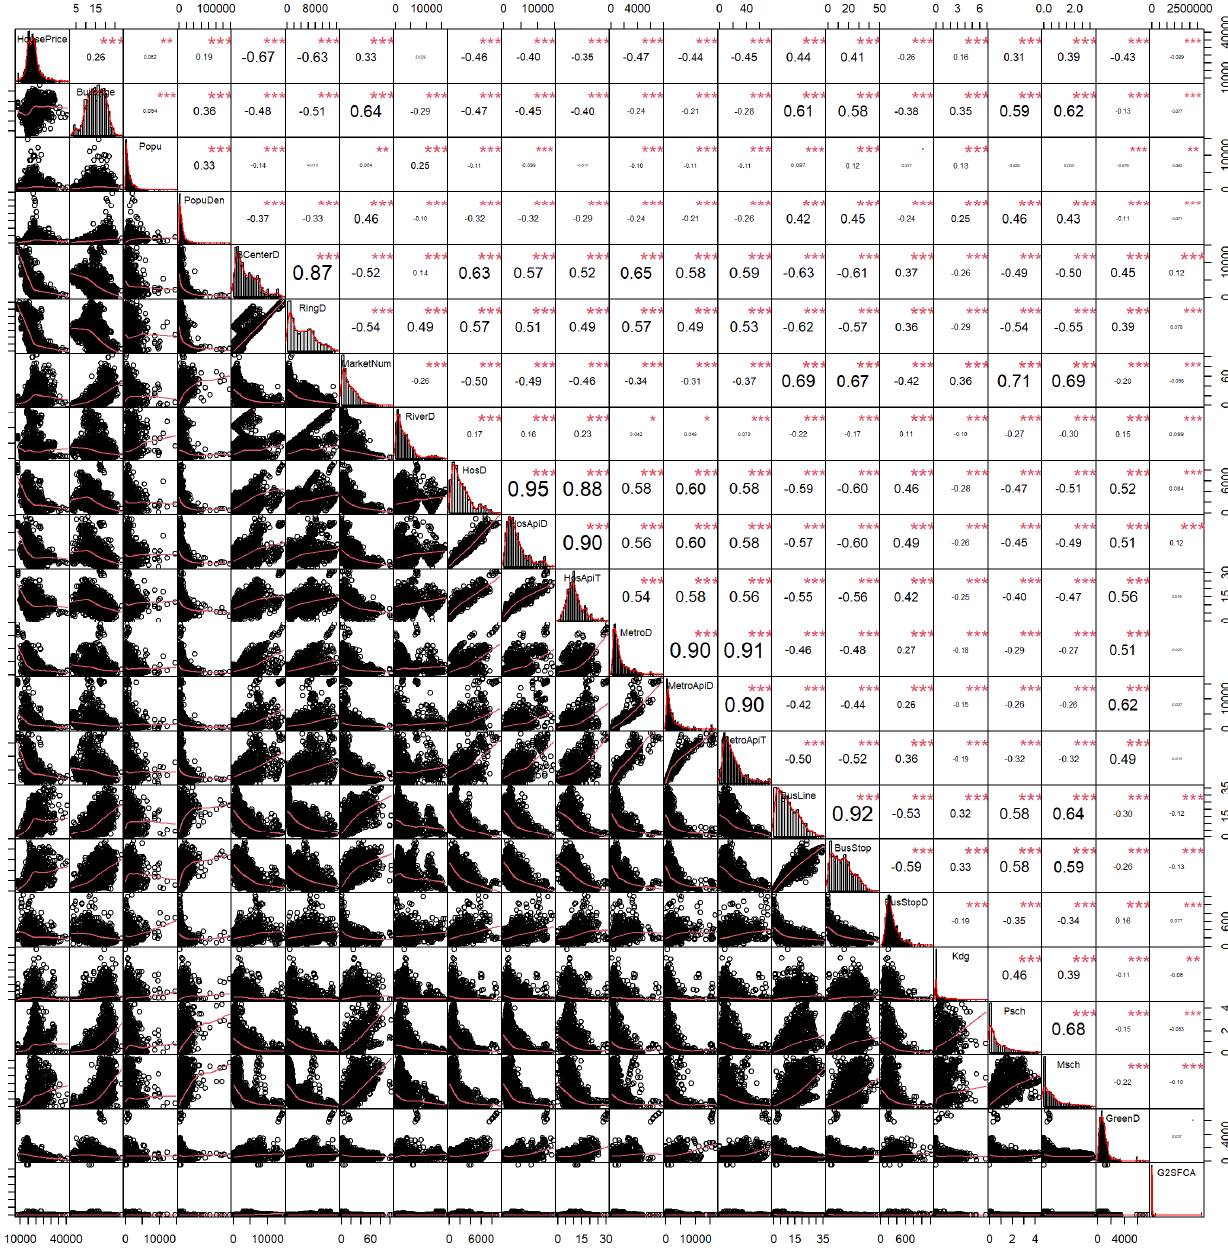
Figure 5. Multimodal accessibility of public facilities. Note: ***, **, * represent significant at the level of 0.001, 0.01, 0.05, respective. Table 2. Step OLS regression result.